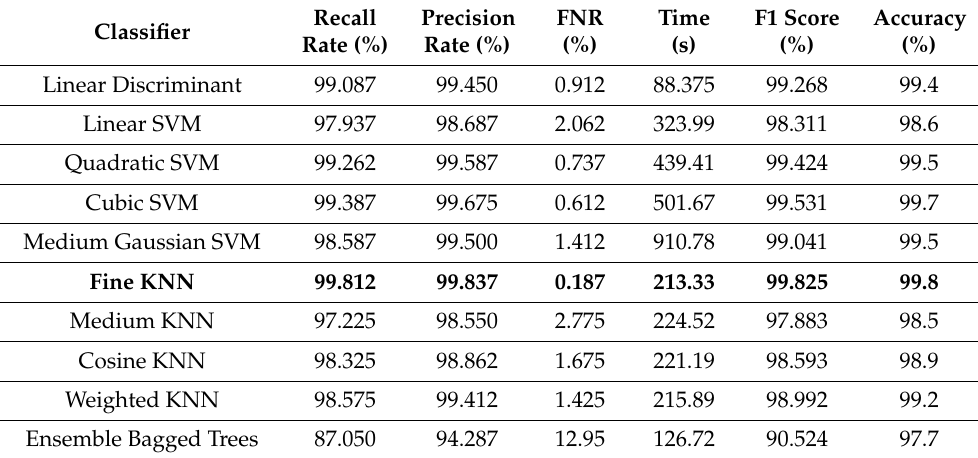
Table 8. Achieved results on Hollywood dataset after best feature selection using KcWKNN. The bold represents the best obtained values.